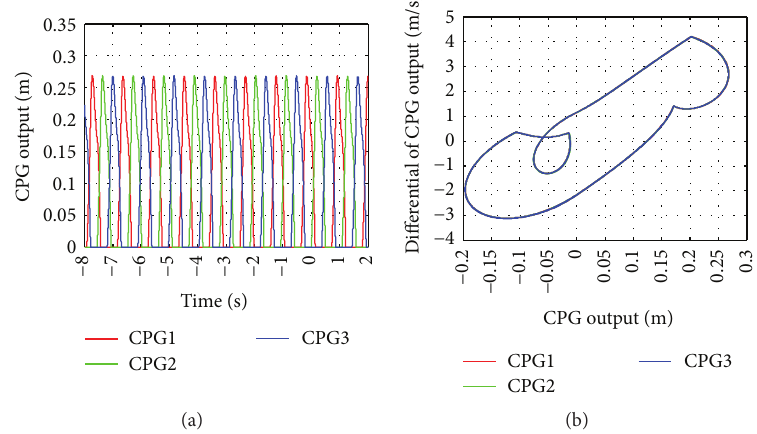
Figure 2: Outputs and phase diagrams of three CPGs: (a) the CPGs outputs and (b) the phase diagrams of these CPGs.